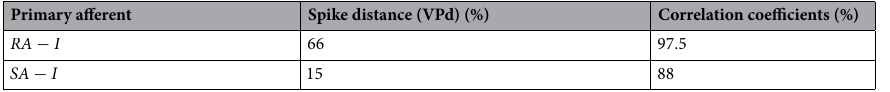
Table 1. Classification performance of the sampled afferents for the scanned edge experiment across their receptive fields: taking into account the spike distance (VPd) and correlation coefficients as the input features to the KNN classifier.